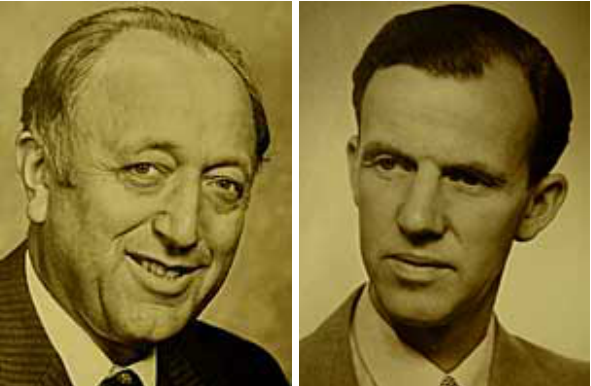
Figure 6: Haakon Sandvold (Left, 1972) and Robert Major (Right,